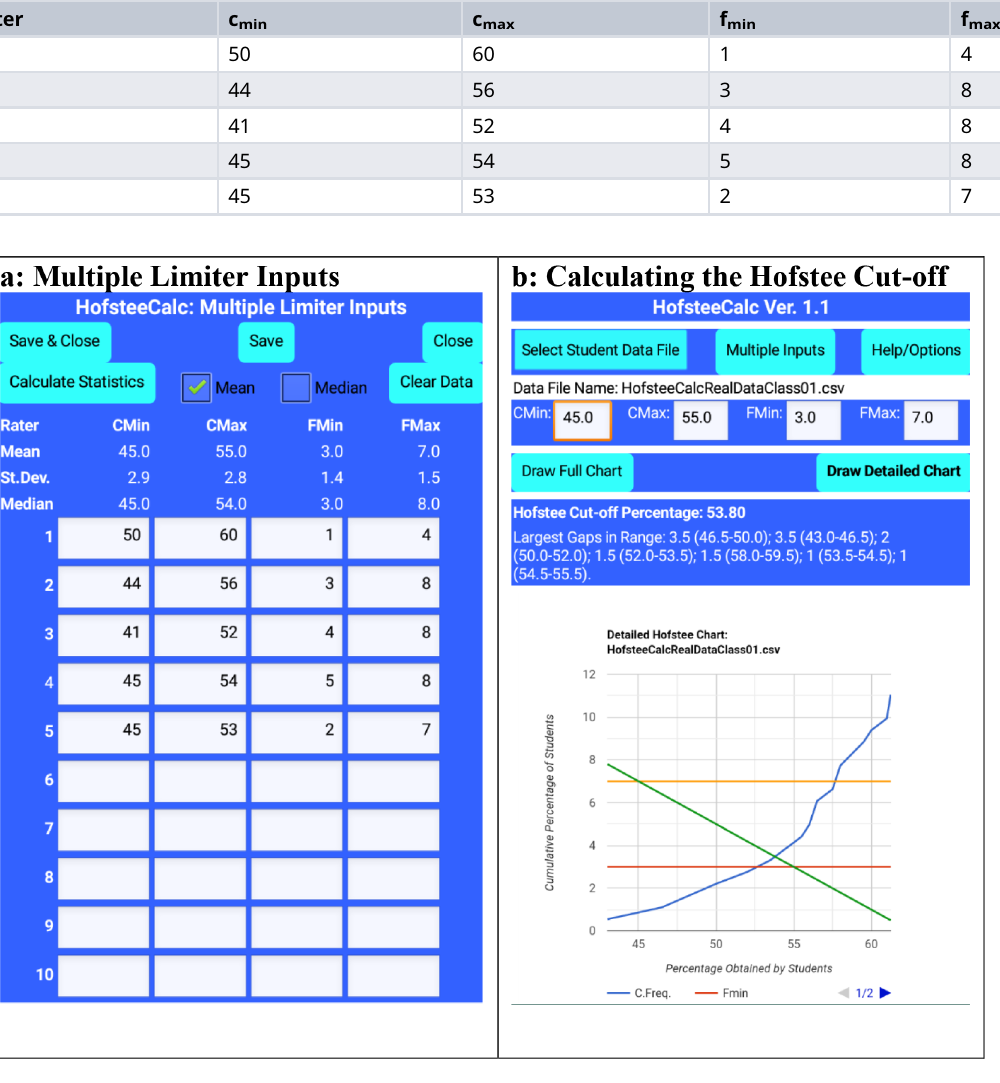
Figure 4. HofsteeCalc app: multiple judges ’ parameters and output from HofsteeCalcRealDataClass01.csv, wherec min is minimum cut-off score,c max ismaximum cut-off score, f min is the lowestpercentageof students thatthe judge feels should fail,and f max is the highest percentage of students thatthe judge feels should